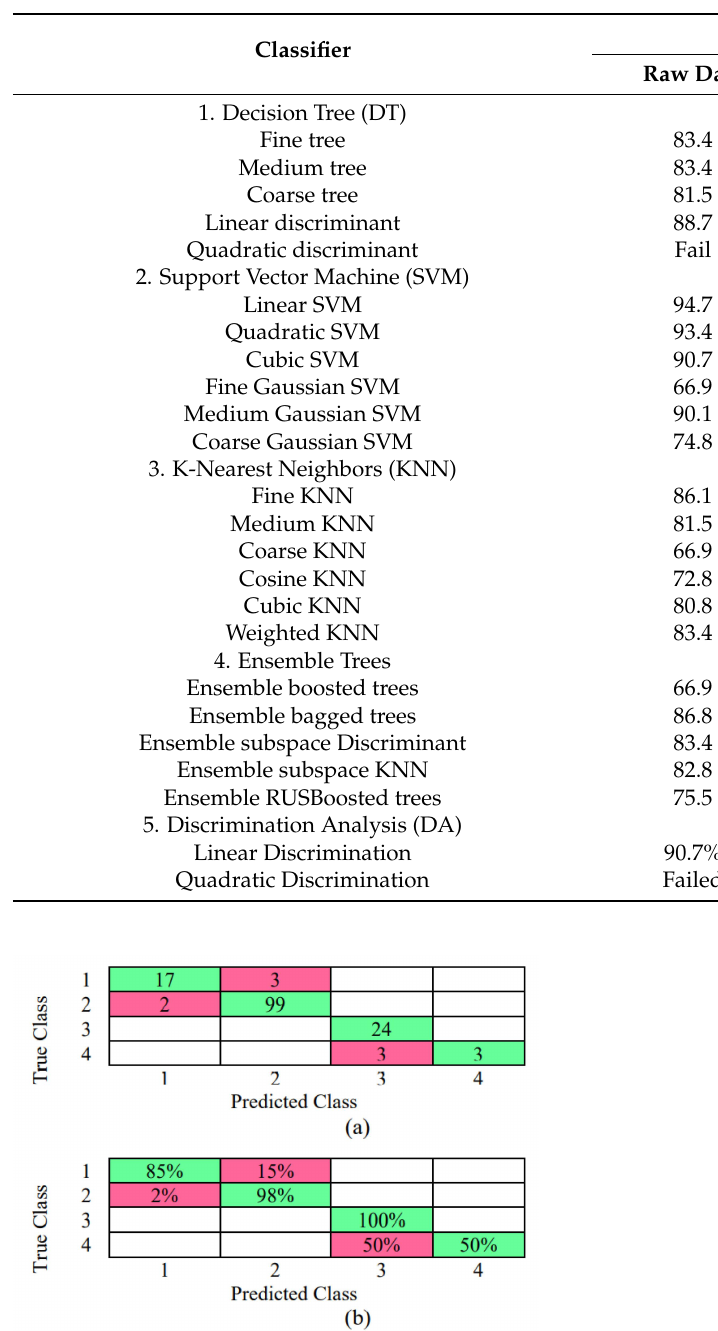
Table 5. Comparison between different classifiers.